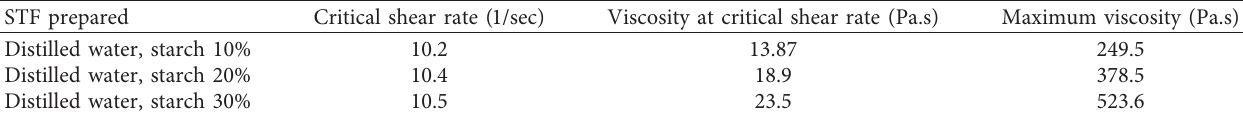
Table 2: Rheological specifications of STFs prepared with starch and distilled water.